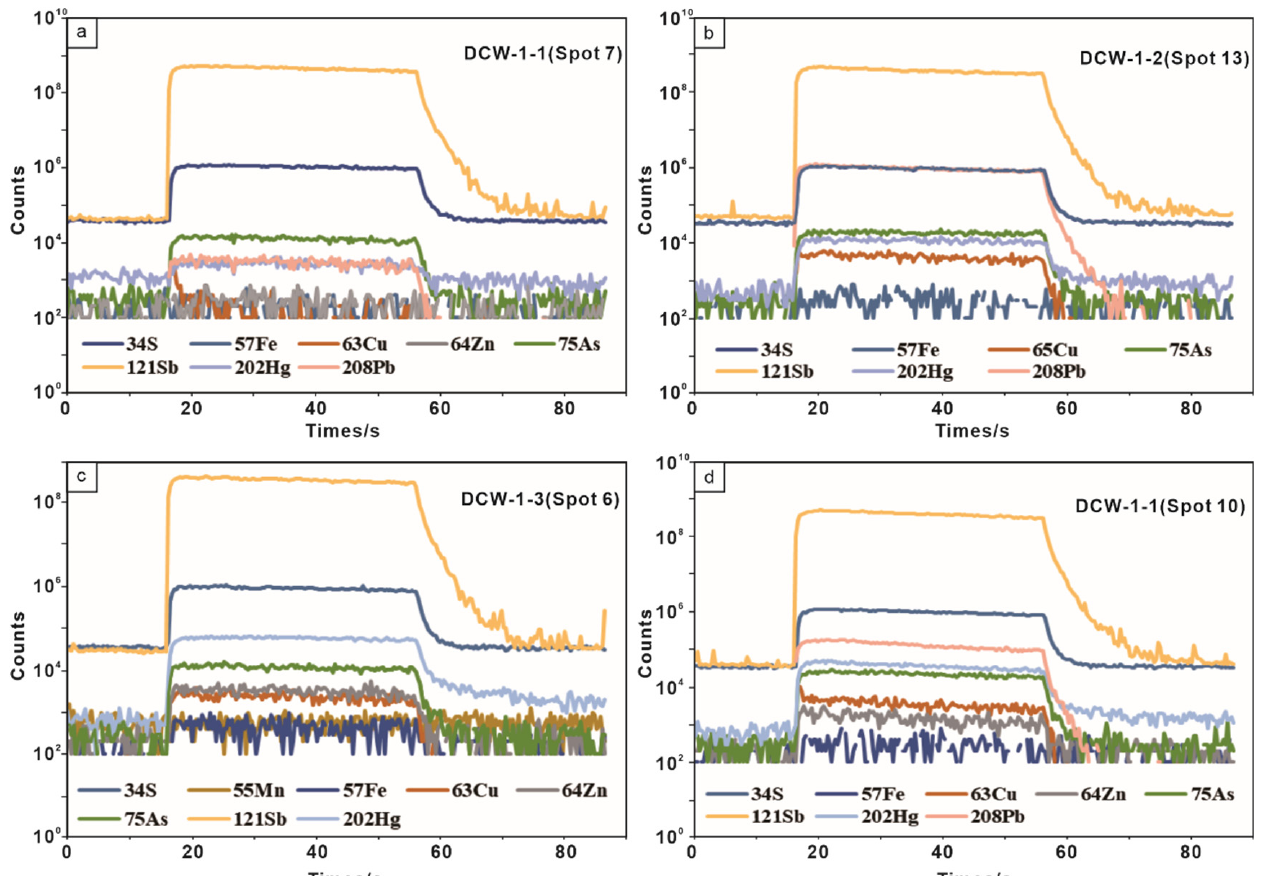
Figure 10. Representative single-spot LA-ICP-MS depth profiles of selected elements in stibnite from the Daocaowan Sb deposit. ( a ) DCW-1-1 (Spot 7). ( b ) DCW-1-2 (Spot 13). ( c ) DCW-1-3 (Spot 6). ( d ) DCW-1-1 (Spot